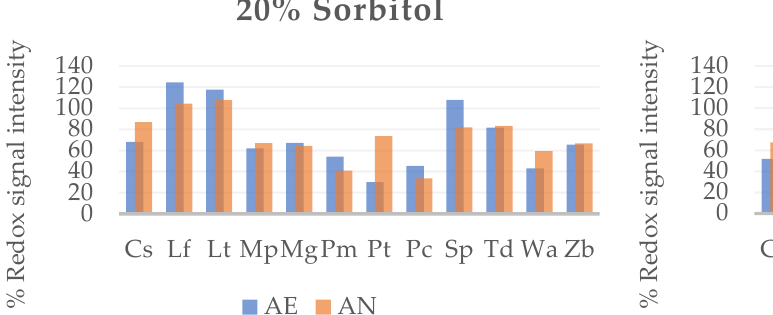
020406080100120140 Figure 1. Metabolic output expressed as redox signal intensity of non- Saccharomyces yeast strains under high osmotic pressure. ( a ) Growth ratio under stress situations generated by 20% of sorbitol medium in aerobic and anaerobic conditions; ( b ) Growth ratio under stress situations generated by 30% of sorbitol medium in aerobic and anaerobic condition.